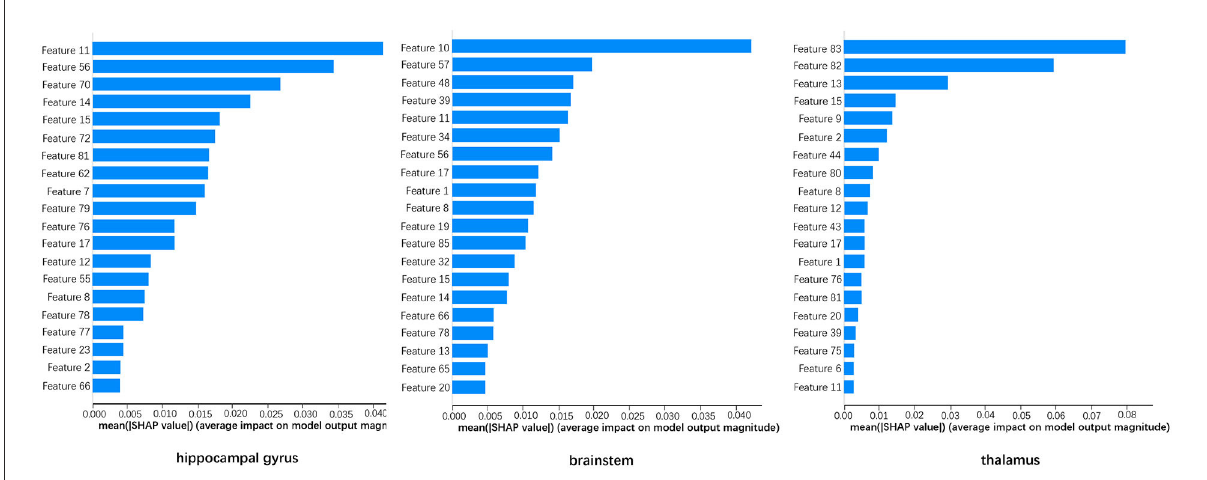
FIGURE2 Feature importance based on SHAP value of hippocampal gyrus, brainstem, and thalamus.